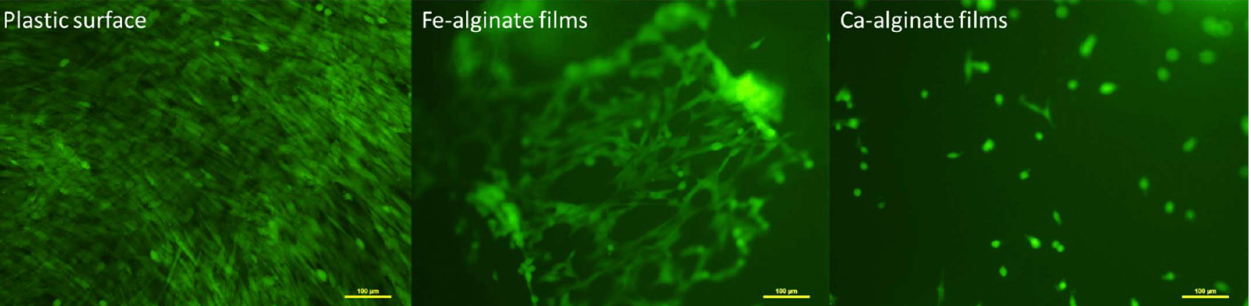
Figure 2. Representative observations of 3 independent cultures of MSCs (fluorescence microscopy) attached on control plastic surface, Fe-alginate or Ca-alginate films (Day 7 after seeding). Cells appear green due to self-produced GFP.